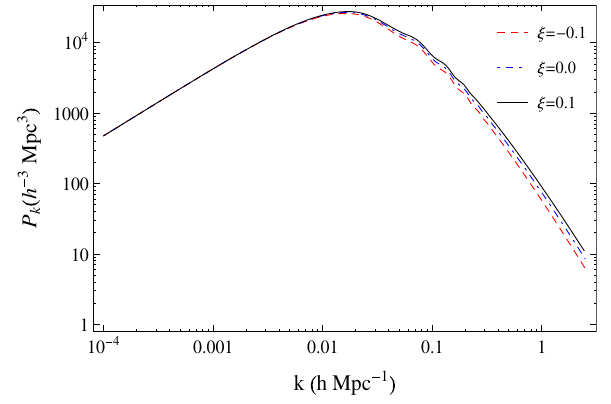
Fig. 2 The matter power spectrum for ξ = − 0 . 1 ( dashed ), 0 ( dash- dotted ), 0.1 ( solid )